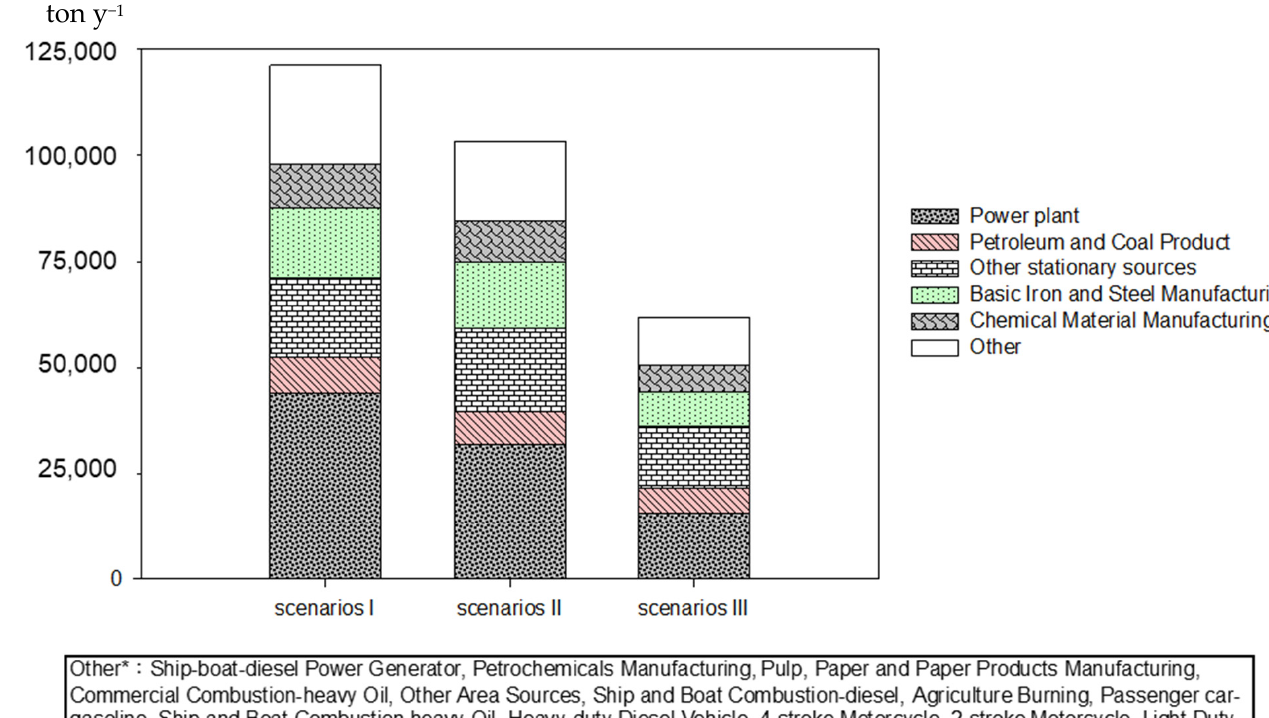
Figure 4. NOx emission sources for different scenarios (ton y − 1 ).